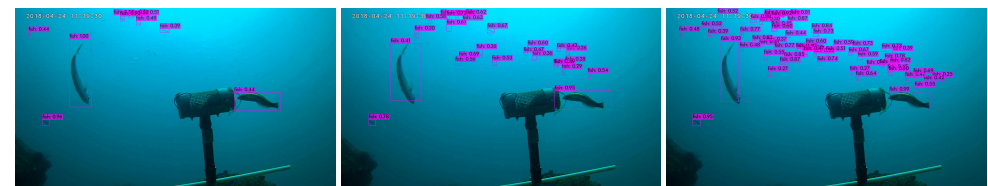
Figure 5. Example of model progression during the self-supervised pseudo-labeling loop cycle (see